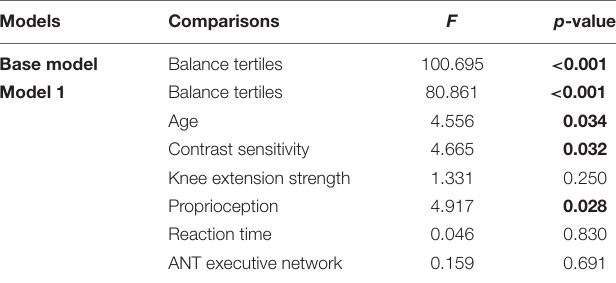
TABLE 2 | Unadjusted (ANOVA) and adjusted (ANCOVA) analyses for the association between postural sway and balance tertiles. Models